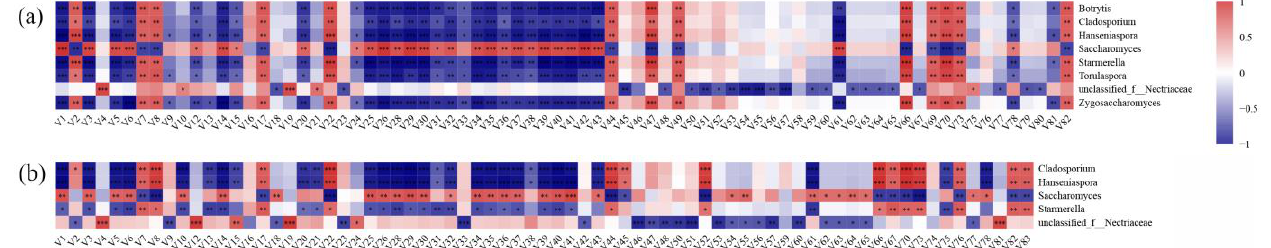
Figure 6. Spearman’s correlation analysis between microorganisms and volatile compounds during fermentation. ( a ) Core fungi in L59 group; ( b ) Core fungi in FX10 group. Note: Positive correlations on the heatmap are shown in brick-red and negative correlations are shown in navy-blue. Volatile compound codes are provided in Table S1. P-values are indicated with asterisks (*). * 0.01 < p < 0.05, ** 0.001 ≤ p < 0.01, *** p < 0.001; ns indicates no significance.